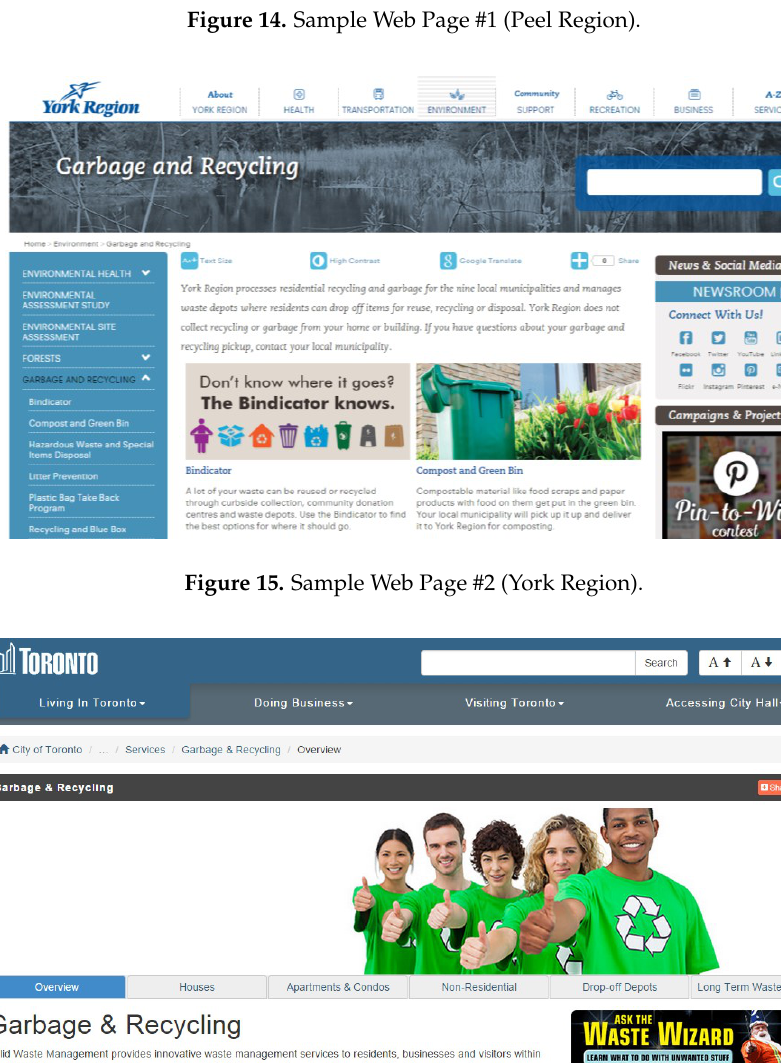
Figure 14. Sample Web Page #1 (Peel Region). Soc. Sci. 2016 , 5 , 23